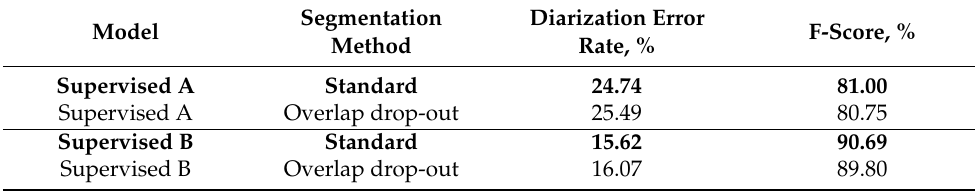
Table 3. Experiment 3